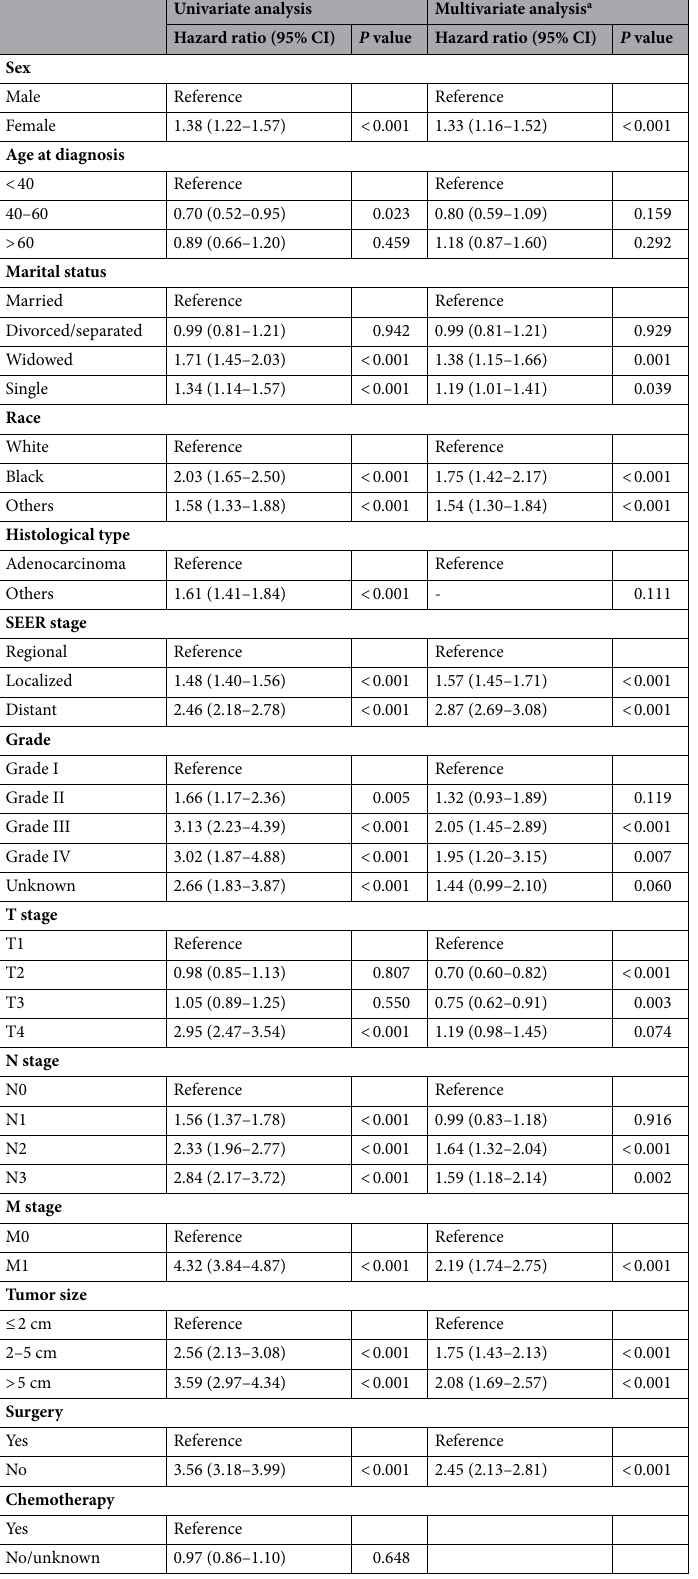
Table 3. Univariate and multivariate analysis of cancer-specific survival (CSS) rates in the training cohort. CSS cancer-specific survival, SEER surveillance, epidemiology, and end results. a Model was adjusted by sex, age at diagnosis, marital status, race, histological type, SEER stage, grade, TNM stage, tumor size and